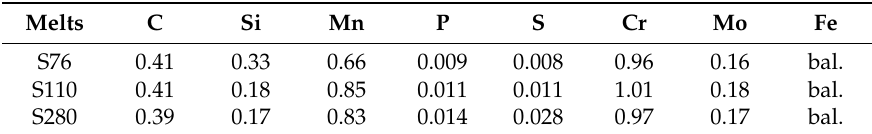
Table 1. Chemical compositions (wt %).